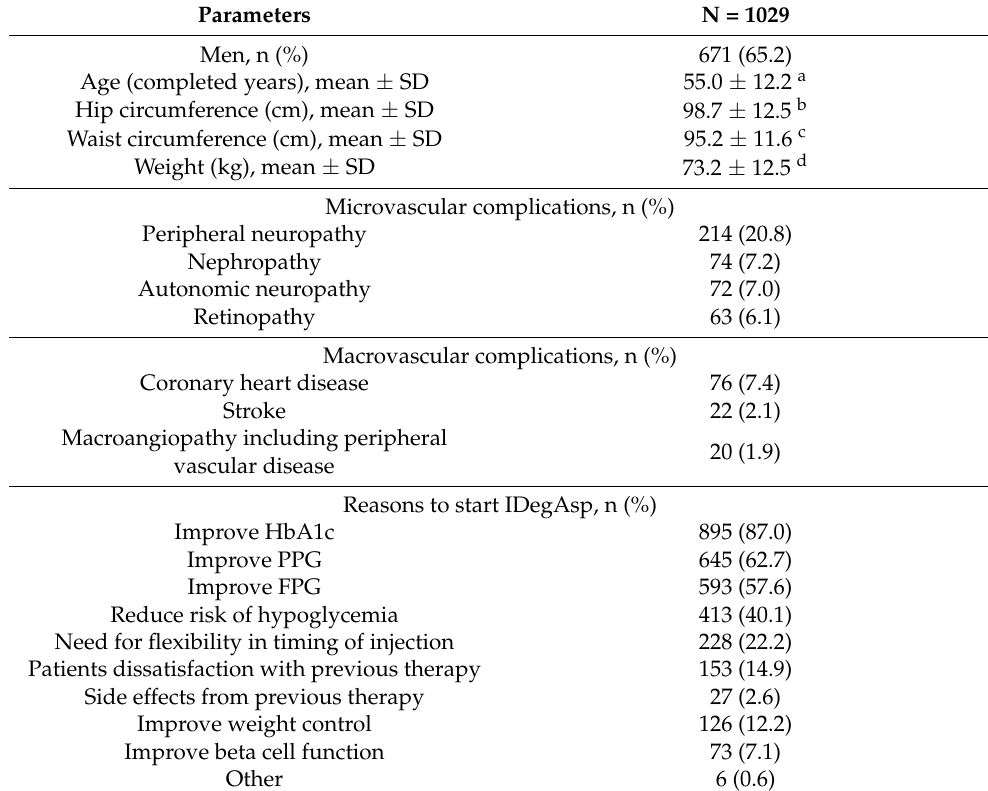
Table 2. Demographics and other baseline medical